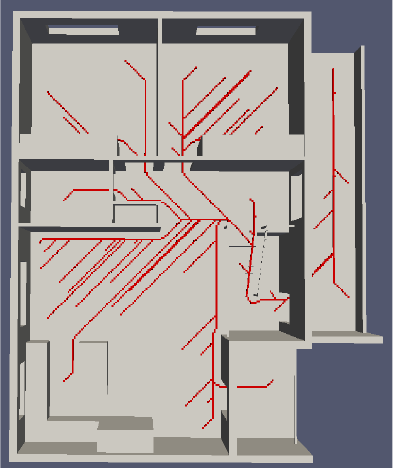
Fig. 3 : Paths to the exit from a number of randomly selected source points